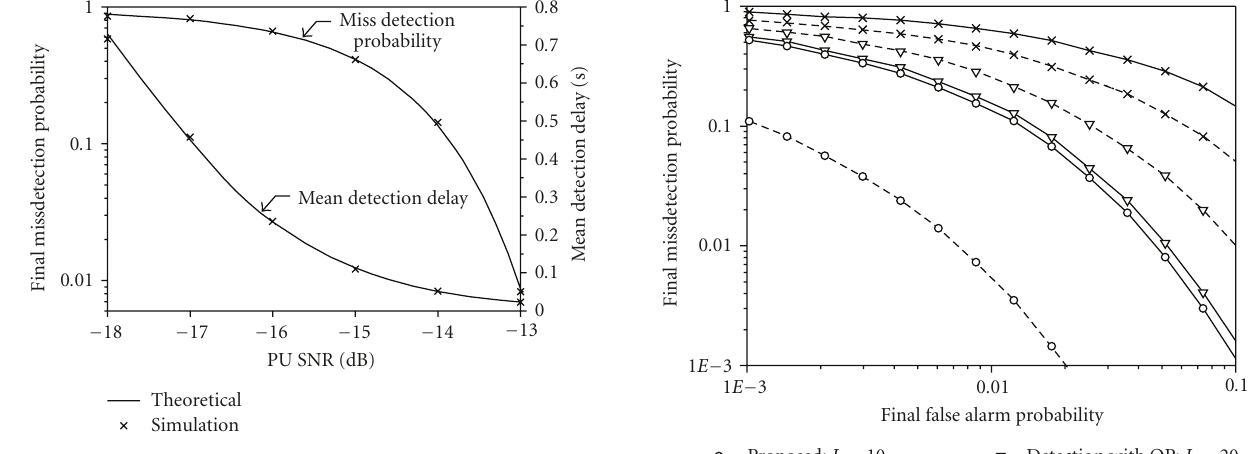
Figure 3: Performance of the proposed scheme according to PU SNR. Table 1: Parameter values for performance evaluation.